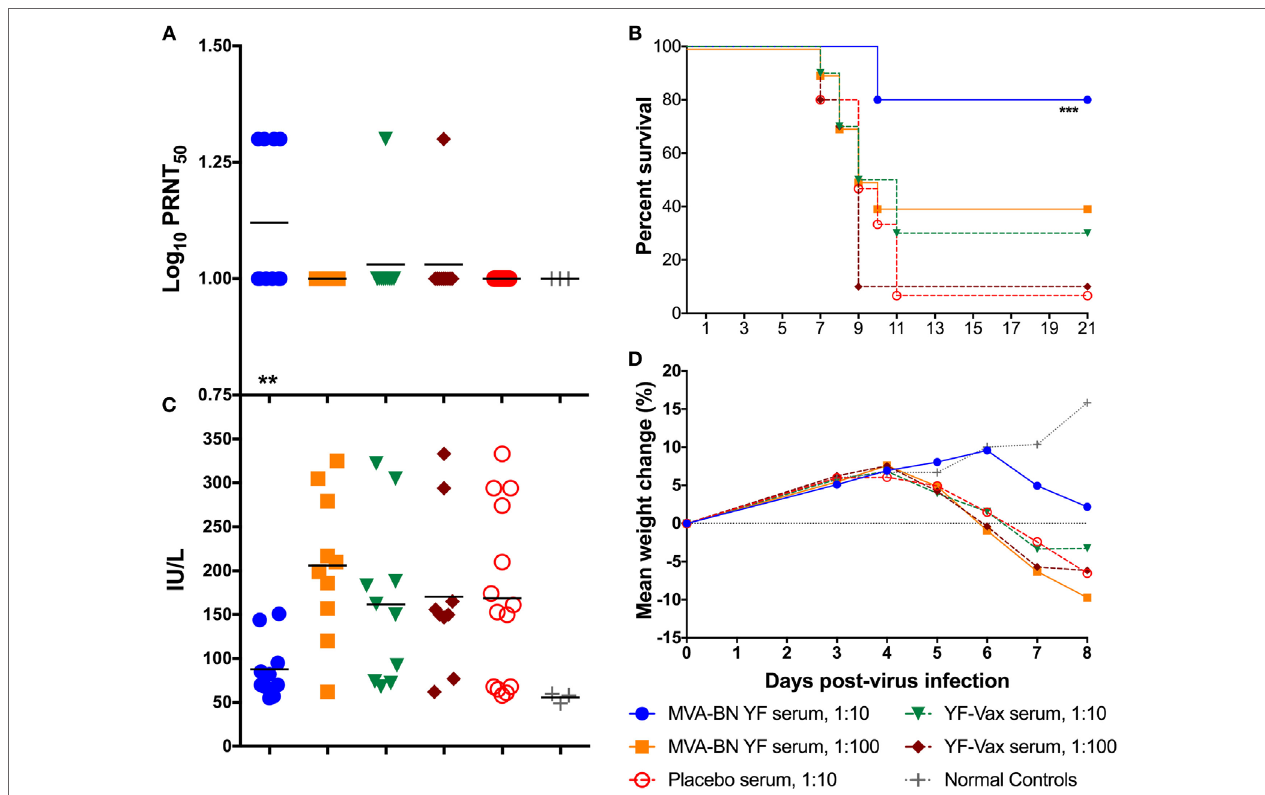
FigUre 2 | (a) Passive administration of serum from hamsters vaccinated with MVA-BN YF or YF-VAX ® resulted in low levels of neutralizing Ab in naïve hamsters ( n = 10/group) present 24 h after treatment. (B) Survival of hamsters after passive administration of serum from vaccinated hamsters. Passive transfer was only significantly protective in hamsters receiving a 1:10 dilution of serum from hamsters vaccinated with MVA-BN YF. (c) Serum alanine aminotransferase on 6 days post challenge for individual hamsters passively immunized with various dilutions of immune serum generated after immunization with MVA-BN YF or YF-VAX ® . (D) Time-course weight change from 0 to 8